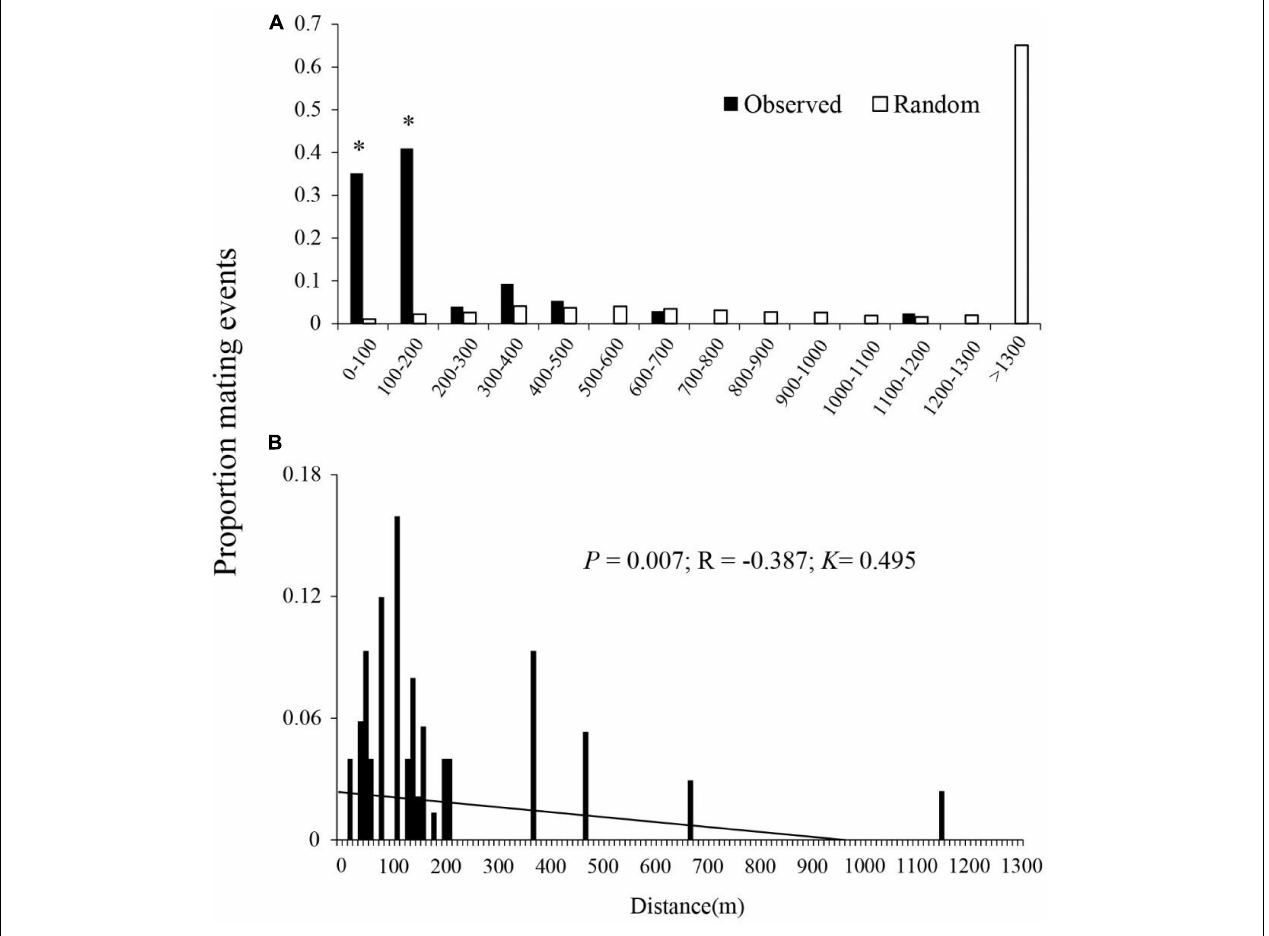
FIGURE 3 | Proportion of realized outcross mating events with distance, showing (A) observed and random outcross pollination events with geographic distance (m) between plant pairs and (B) proportion of mating events with ranked distance between plant pairs. Realized mating events are based on the results of a paternity assignment of seeds ( n = 376) collected from 12 B. ceiba . Potential mating events are the distances between maternal trees and all the potential sires. ∗ Significant differences ( P < 0.001) between observed and potential mating